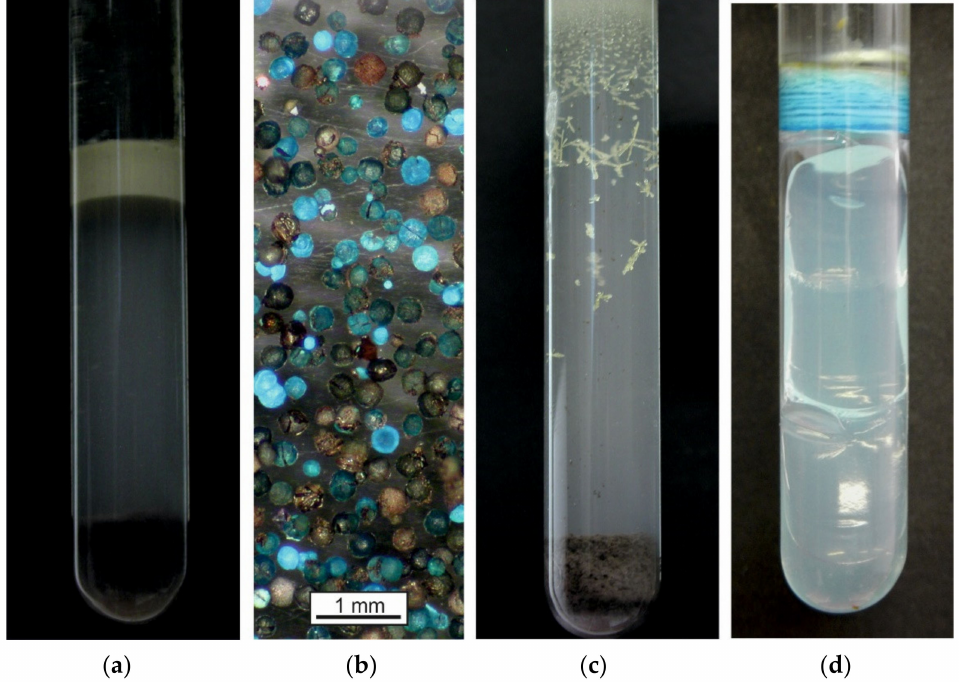
Figure 7. Types of reaction product: ( a ) Colloid of metallic Ag; ( b ) Spherulites of Cu-oxalate dihydrate; ( c ) Crystals of Ag-oxalate; ( d ) ‘Salt lid’ composed of bayerite and minor Cu(OH) 2 . The diameter of the test tubes in ( a , c , d ) is 1